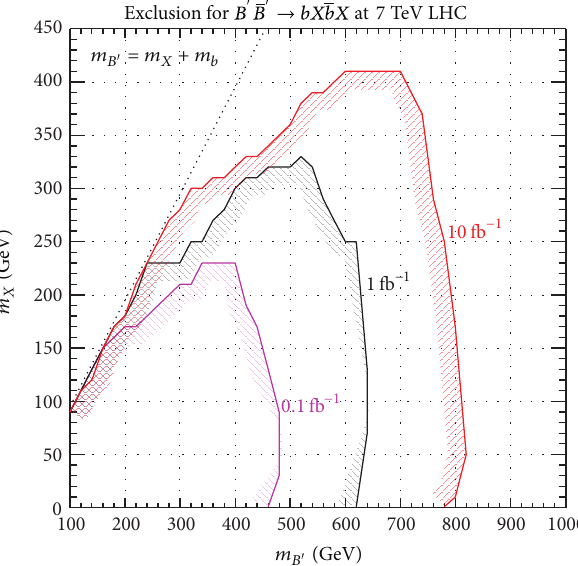
Figure 10: 95% CL exclusion reach in the (𝑚 𝐵 󸀠 , 𝑚 𝑋 ) plane for integrated luminosities of 0.1, 1, and 10fb −1 at 7 TeV LHC. Figure from